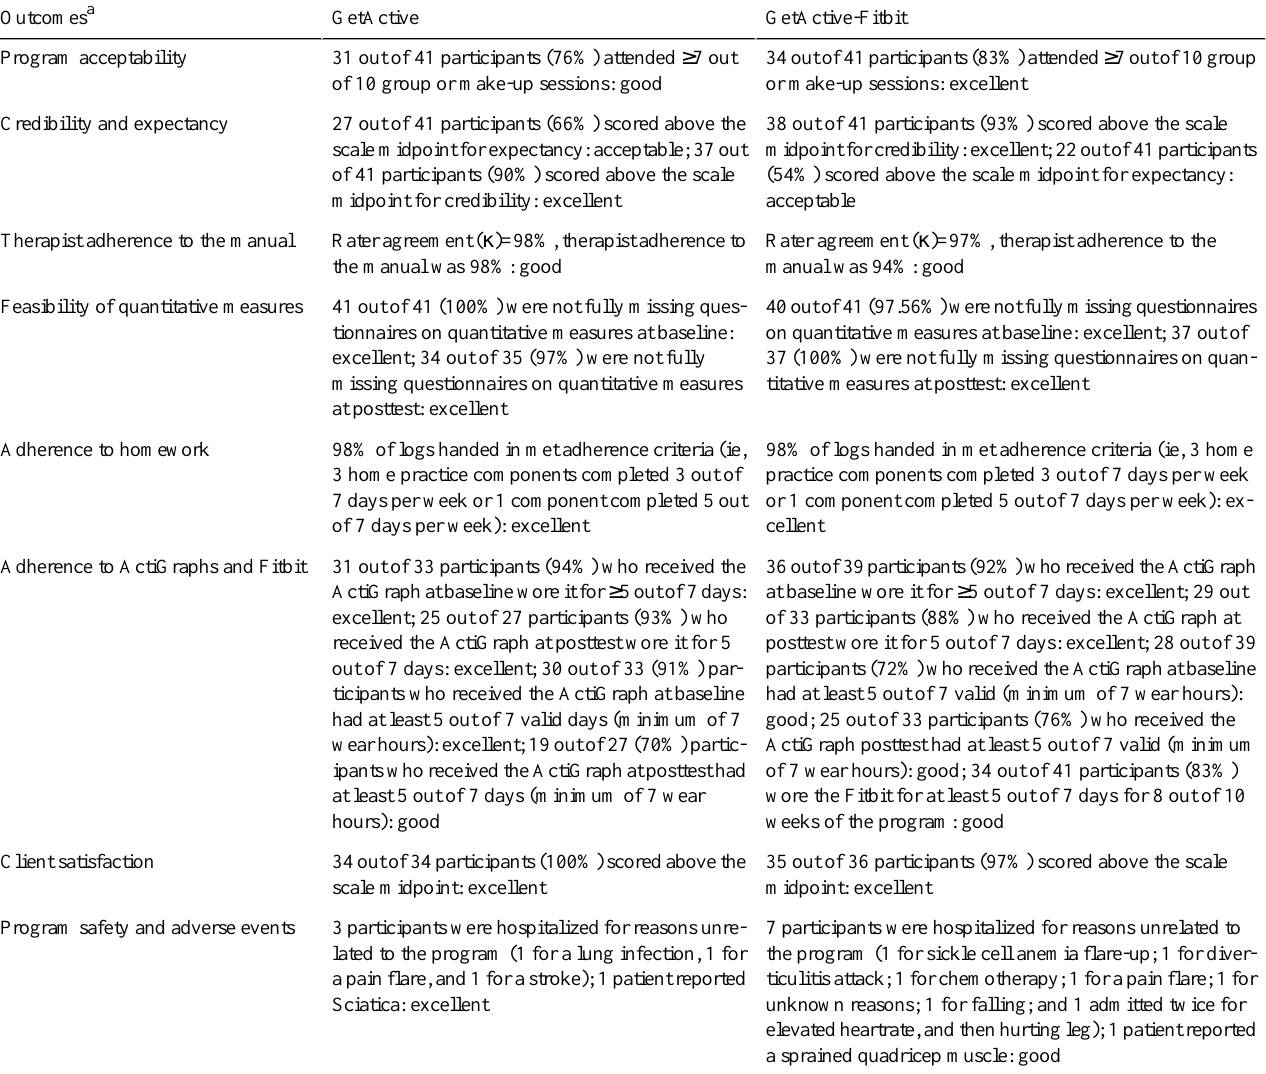
Table 2. Feasibility and acceptability of the